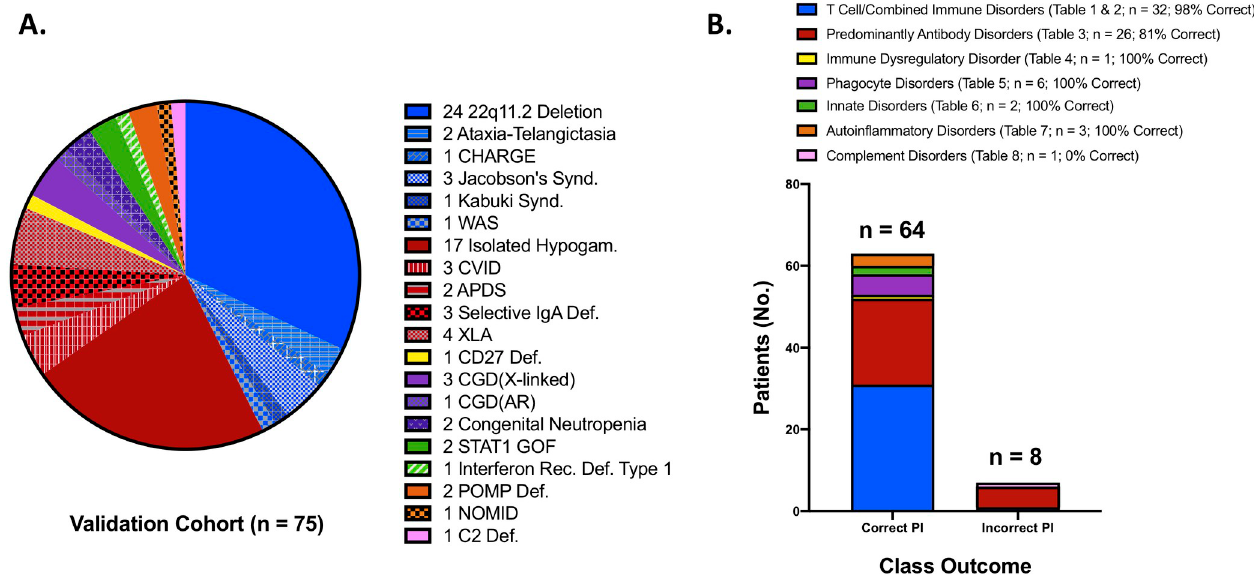
Fig 4. Cohort features & network outcomes. A. Validation cohort disorder spectrum. The IUIS groupings are clustered according to color (i.e. Blue = T/CID; Red = PAD; Yellow = PIRD; Purple = PD; Green = ID; Orange = AID and Pink = CD. B. BN performance for classifying each IUIS category and overall outcome. The legend displays category number and accuracy for our BN prediction. NOTE- 3 patients were not included here since insufficient input data were available and a class outcome could not be defined by the model. (Abbreviations: CHARGE-coloboma, heart disease, atresia of choanae, restricted growth, genital and ear abnormalities; WAS-Wiskott-Aldrich Syndrome; CVID-Common Variable Immunodeficiency; APDS-Activated Pi3K Delta Syndrome; XLA-X-linked Agammaglobulinemia; CGD-Chronic Granulomatous Disease; STAT1 GOF- Signal Transducer Activator of Transcription 1 Gain of Function; POMP-Proteasome Maturation Protein; NOMID-Neonatal Onset Multisystem Inflammatory Disease).